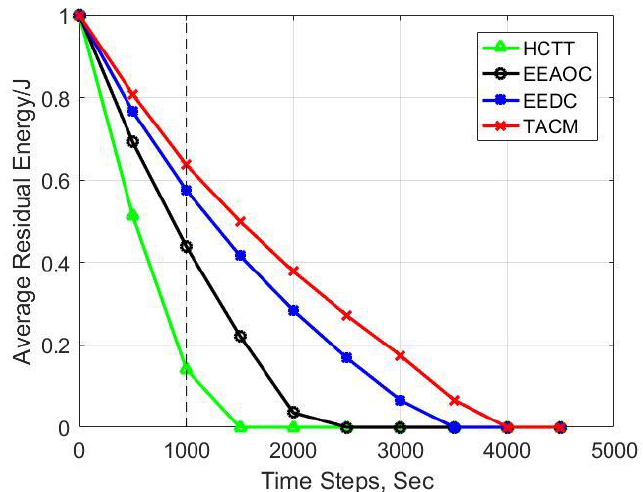
Figure 9. Experimental results for average residual energy of sensor nodes.